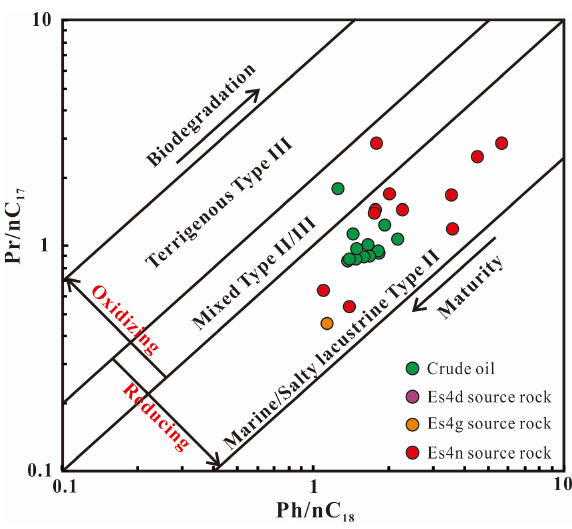
Figure 14. Plot of Pr/ n ‐ C 17 vs. Ph/ n ‐ C 18 showing the sedimentary environment and thermal maturity.